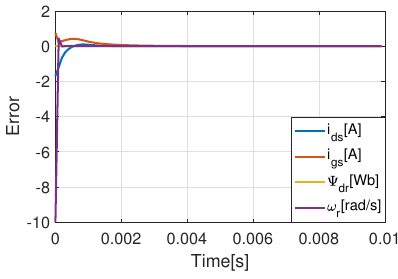
Figure 4. Initial observer